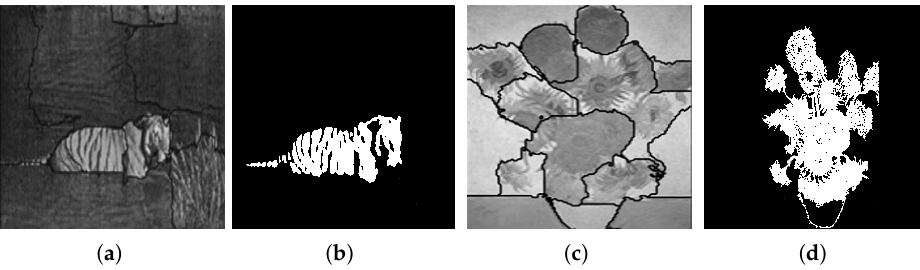
Figure 30. Results obtained using ( a ) the algorithm proposed by Malik et al. [69]; ( b ) the proposed approach; ( c ) the algorithm proposed by Malik et al. [69]; ( d ) the proposed approach. Images ( a , c ) referenced from Malik et al.